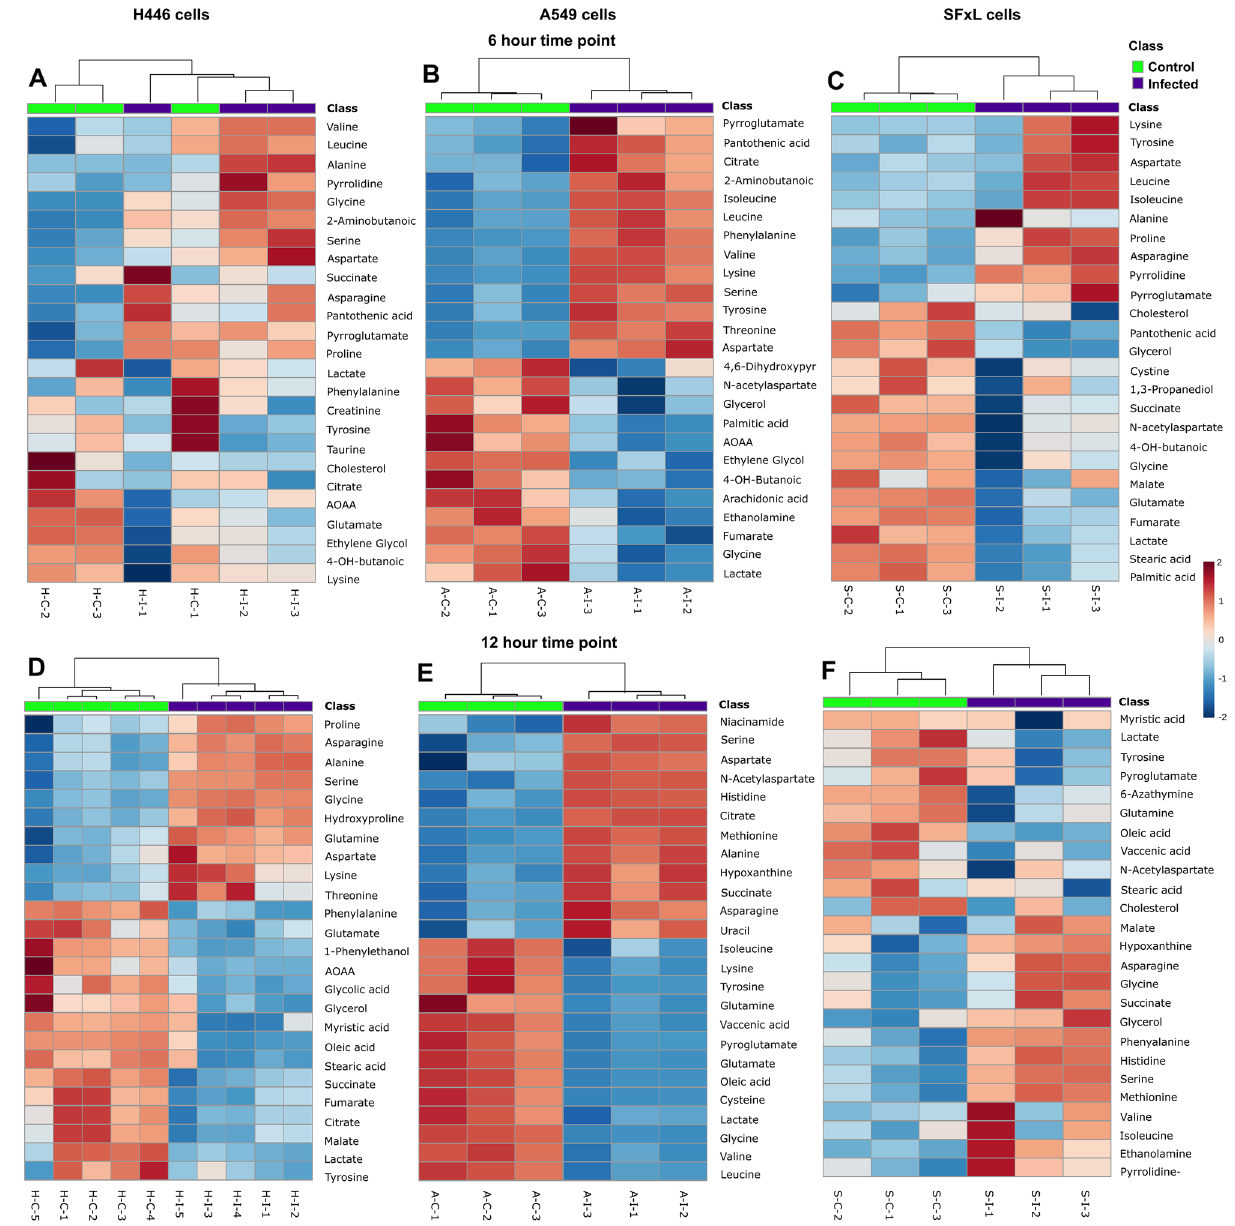
Figure 4. Demonstration of clustering between control and infected cells: Hierarchical clustering results are shown as heatmaps demonstrating the differences in the levels of top 25 metabolites (identified via Student’s t-test in Metaboanalyst) between control and infected H446, A549, and SFxL cells at 6 h ( A , B , and C , respectively) and 12 h ( D , E , and F ,